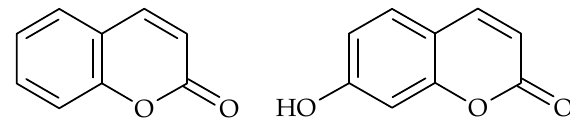
Figure 9. Chemical structures of coumarin ( left ) and umbelliferone ( right ).